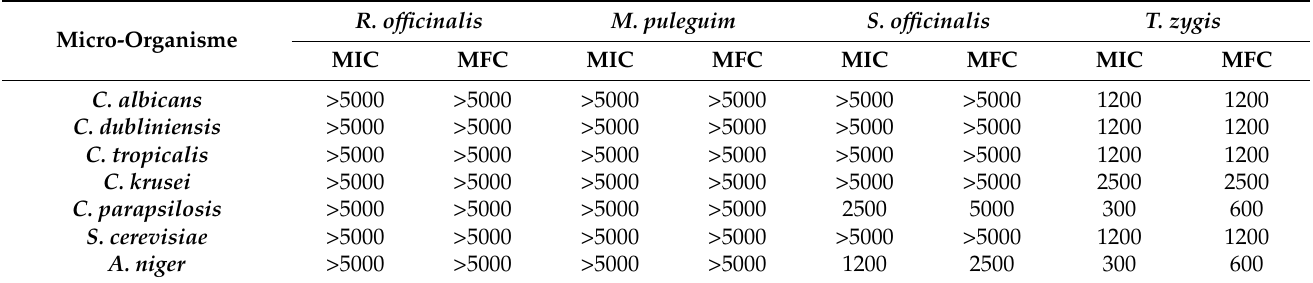
Table 4. Minimum Inhibitory Concentration (MIC) and Minimum Fungicide Concentration (MFC) of EOs of Studied Species ( µ g/mL).